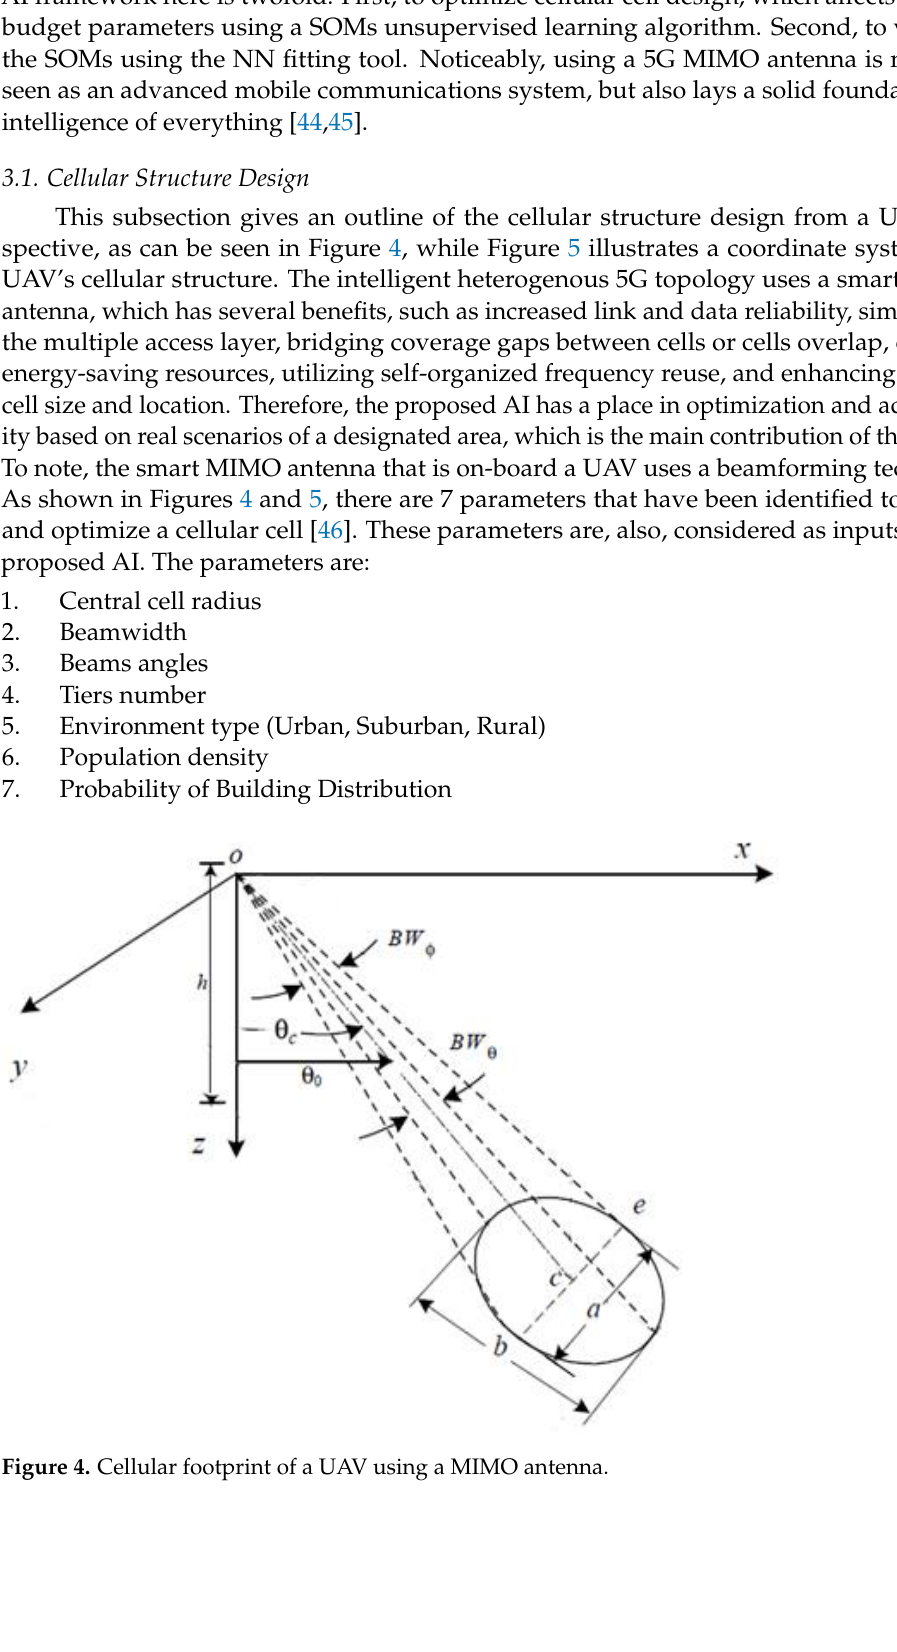
Figure 3. Proposed intelligent heterogenous 5G topology that integrates a UAV-based system with IoE and AI.